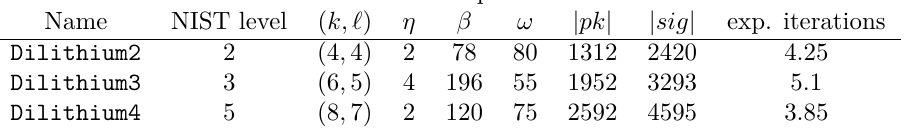
Table 2: Dilithium parameter